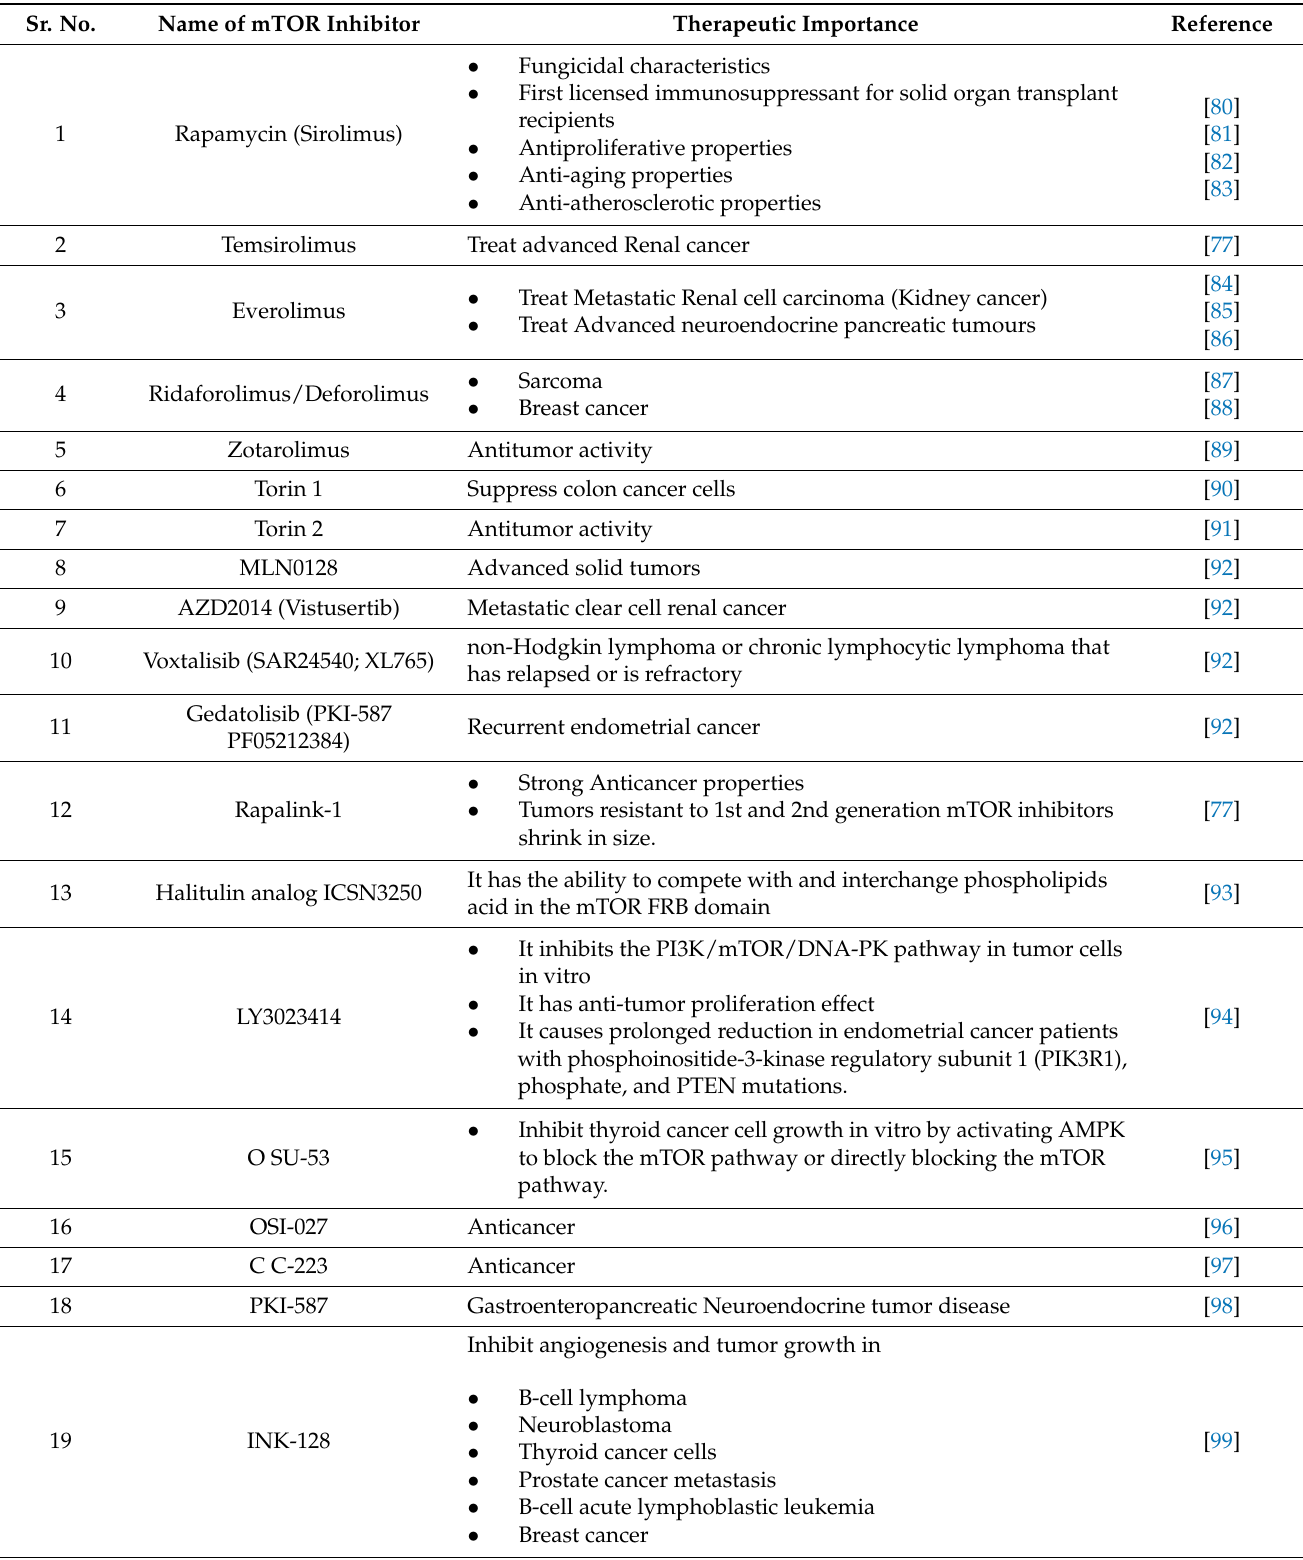
Table 1. mTOR inhibitors and their therapeutic